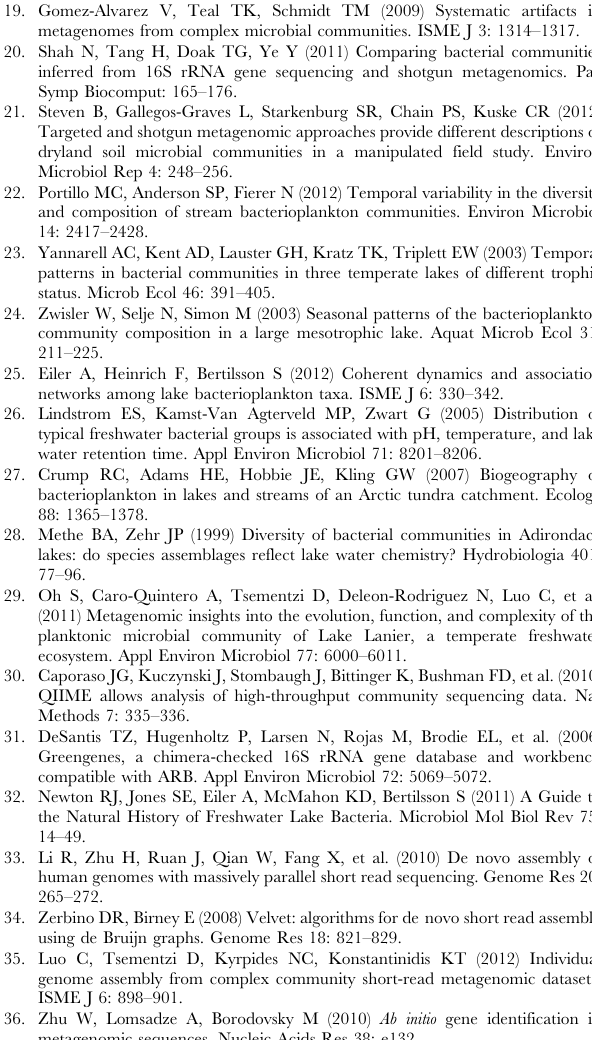
Figure S3 Similarity of datasets based on shared OTUs. Figure S4 Differences in phylum abundance based on 16S and metagen-